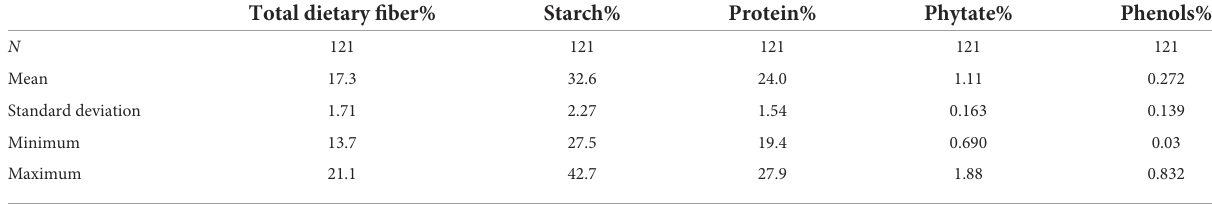
TABLE 1 Descriptive statistics of total protein, starch, TDF, phenols, and phytic acid.